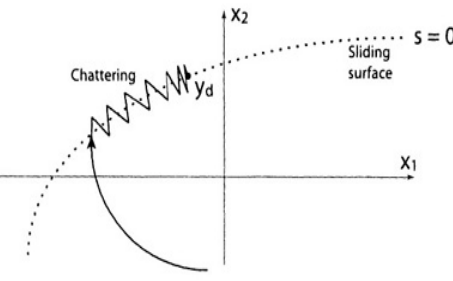
Figure 10. Chattering as a result of imperfect control switching [31].